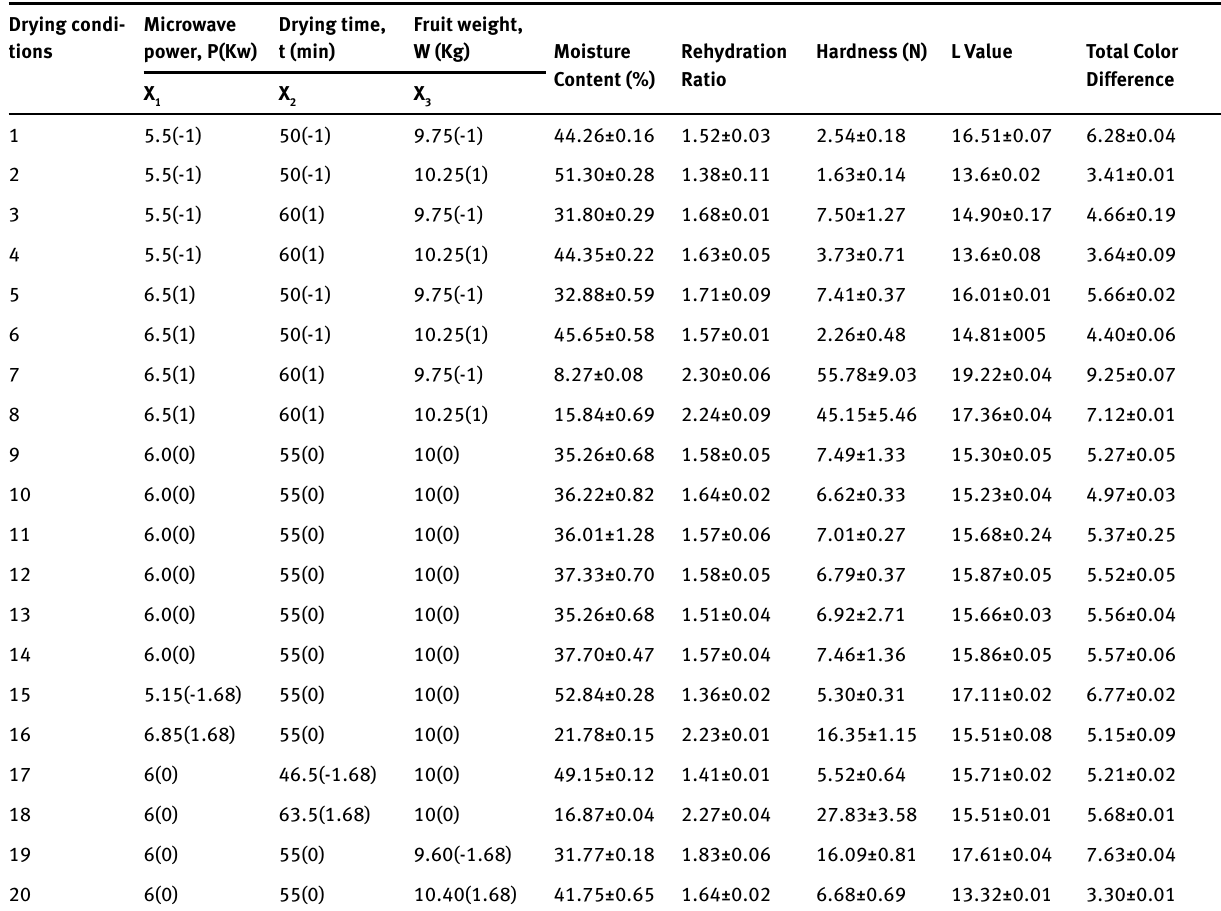
Table 1 Experimental design of microwave-vacuum drying conditions and the experimental results of moisture content, rehydration ratio, hardness, L value and color difference of dried Saskatoon berries Drying condi-